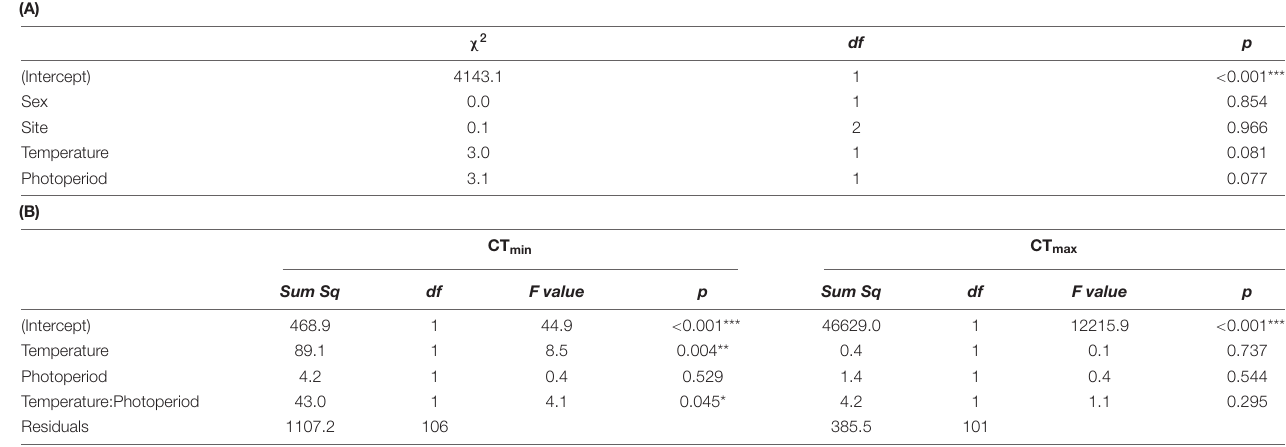
Stars indicate significant effects (*: p < 0.05, **: p < 0.01, and ***: p < 0 .001).